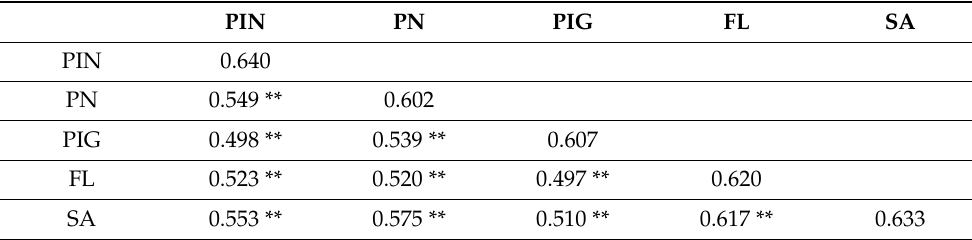
Table 9. Discriminant validity results.